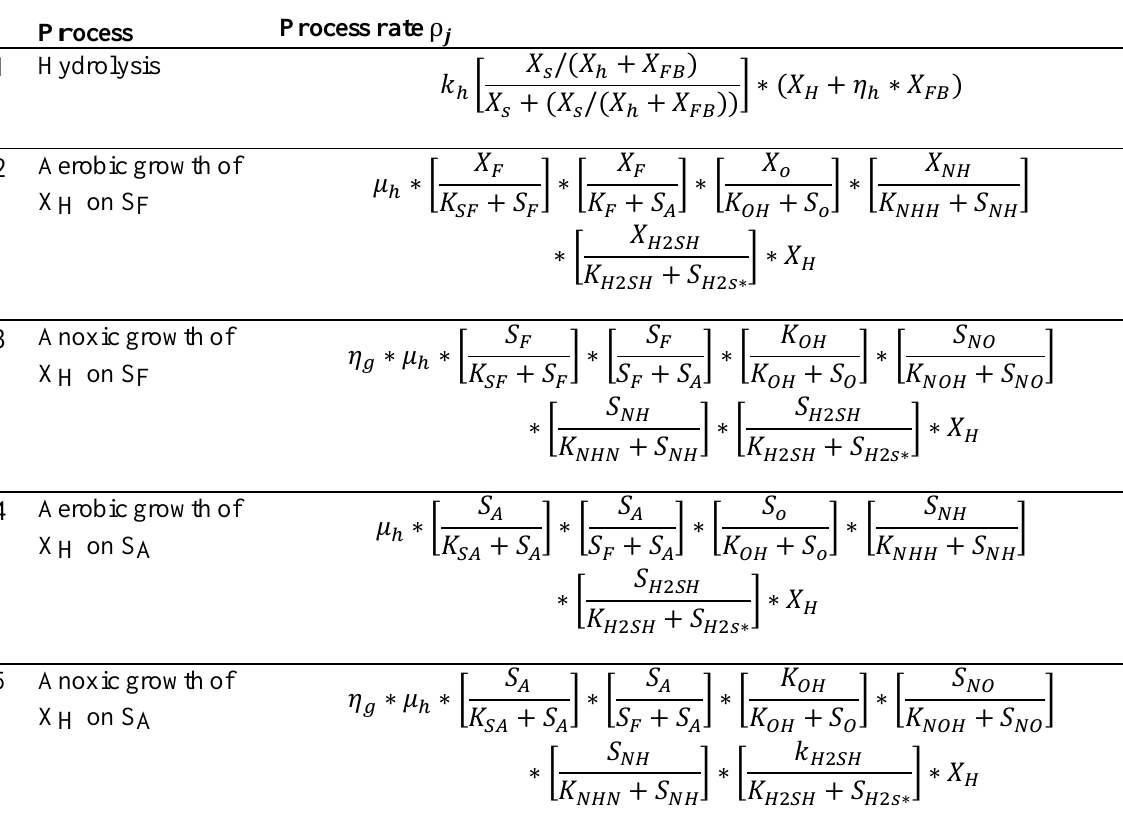
Table 3. Processes rates in CWM1 matrix ( Langergraber et al 2009, Rousseau,